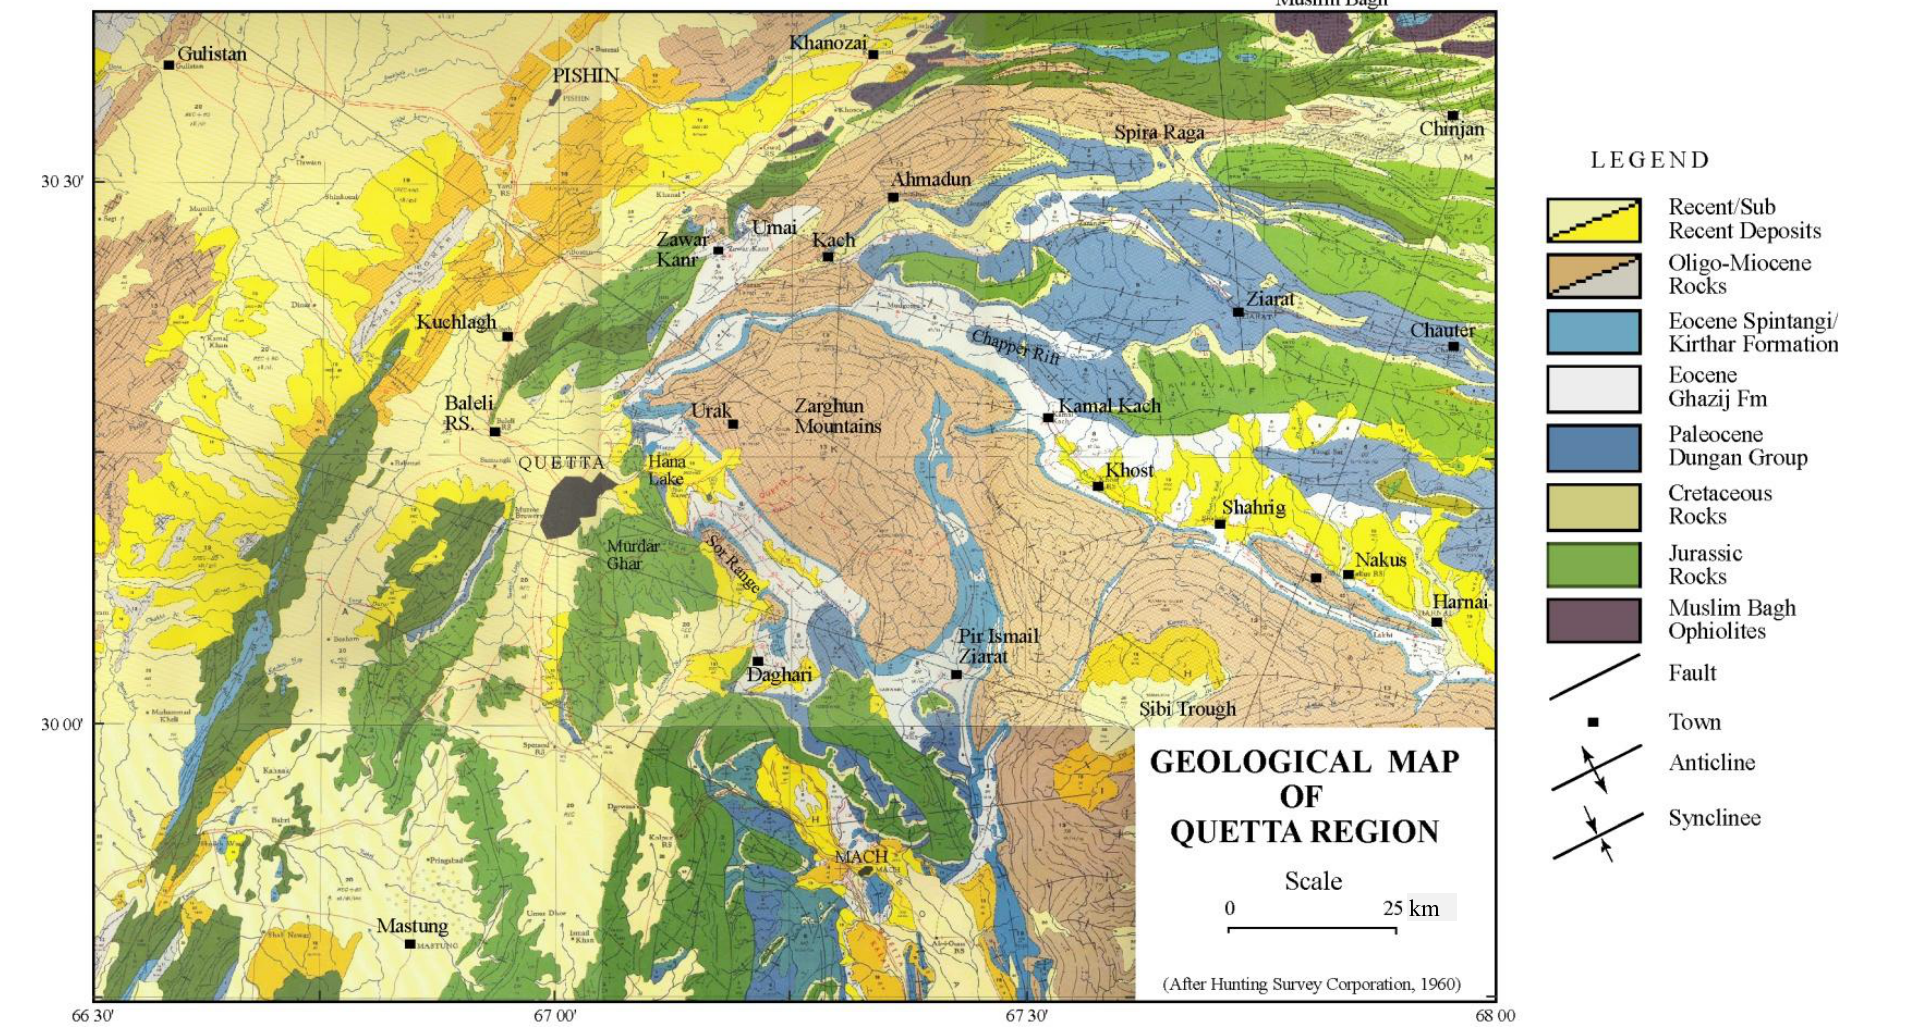
Figure A2. Geological map and geographic localities of the Quetta Region (adapted from Hunting Survey Corporation [52]).